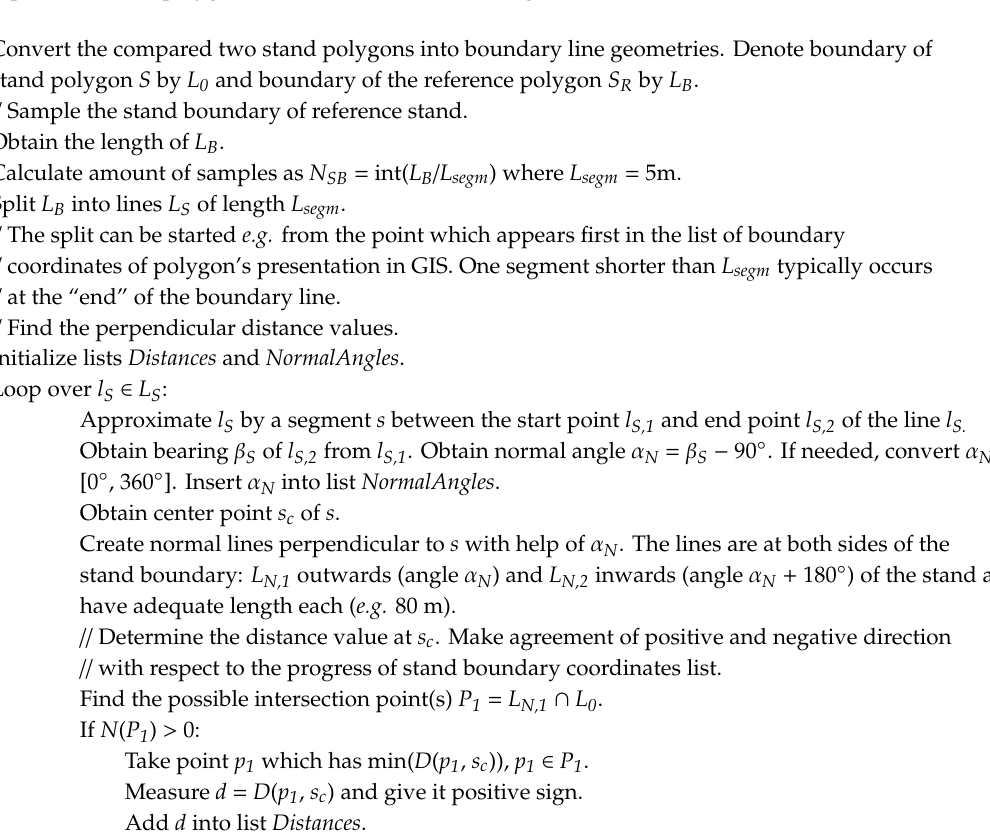
Determining perpendicular distances between stand